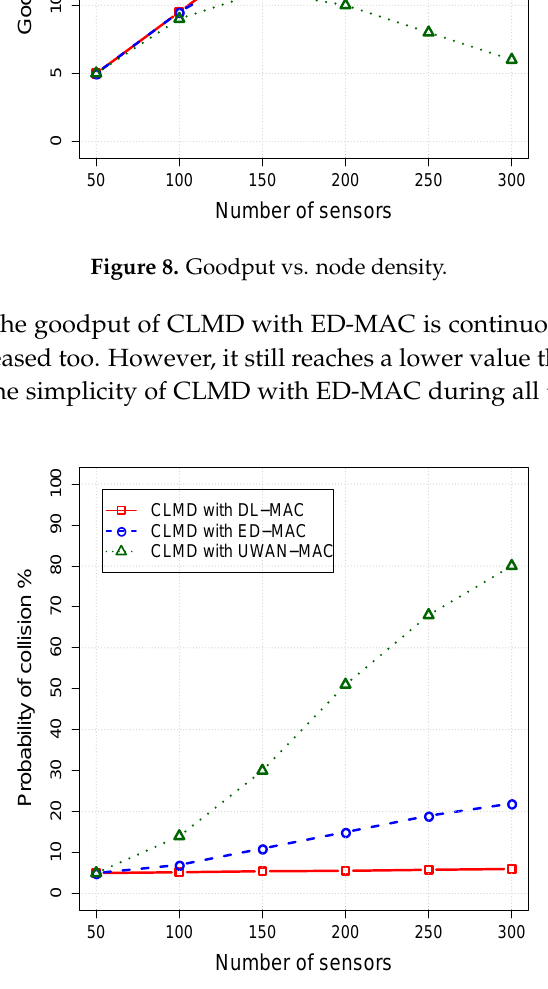
Figure 9. Probability of collision vs. node